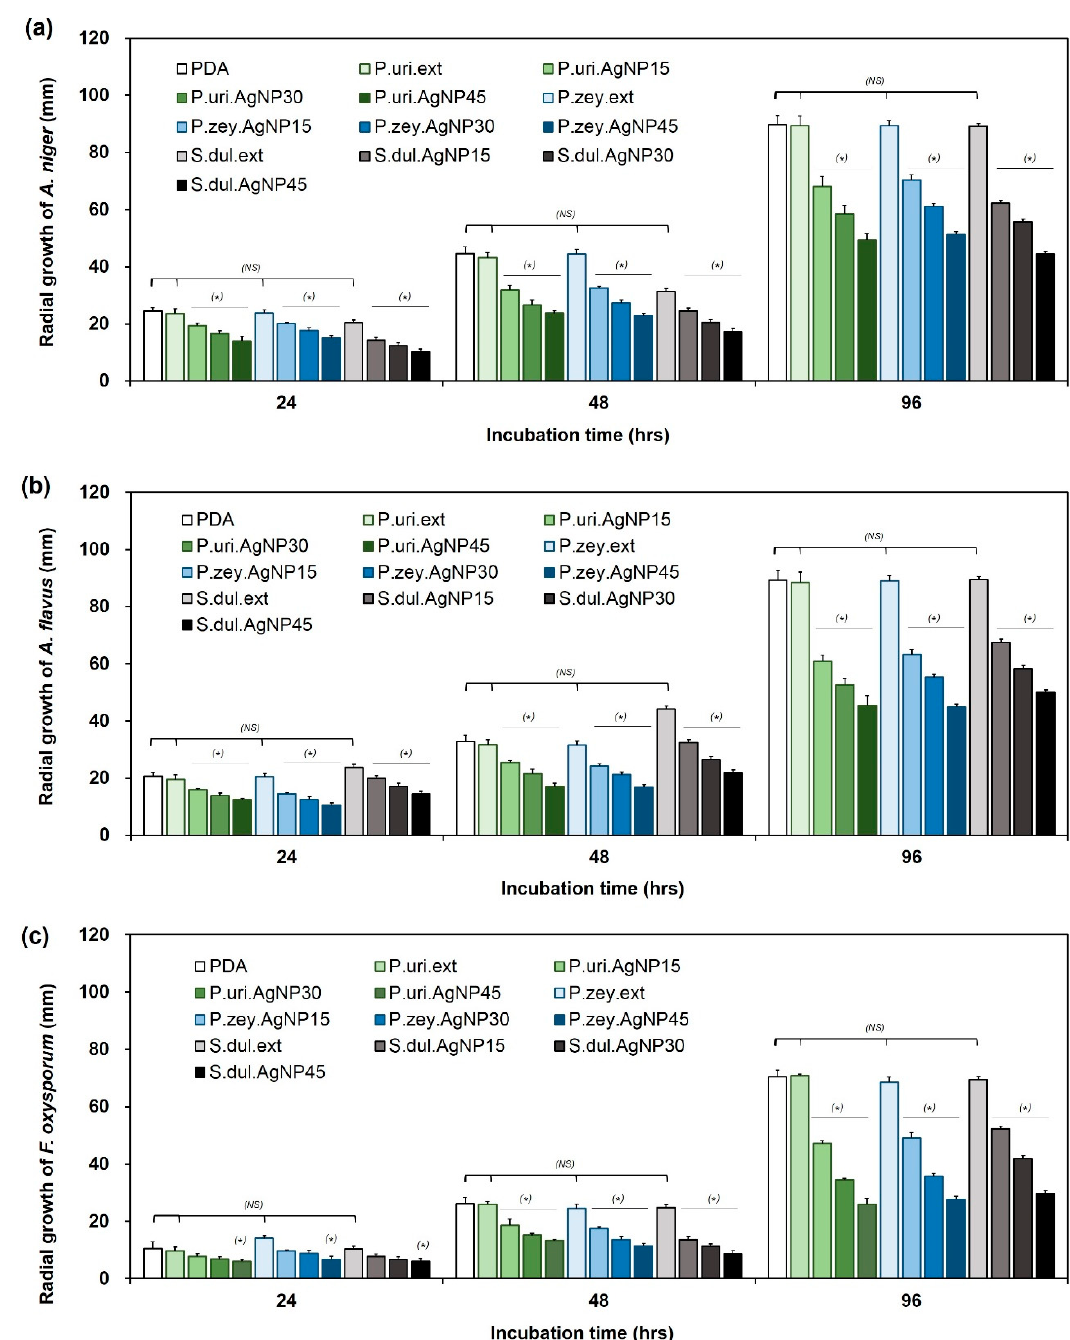
Figure 5. The mycelium diameter of A. niger ( a ), A. flavus ( b ) , and F. oxysporum ( c ) cultured on different agar matrices as a function of time interval. (PDA: potato dextrose agar dishes as a control; P.uri.ext, P.zey.ext, and S.dul.ext: the dishes made from PDA containing leaf extracts of Phyllanthus urinaria, Pouzolzia zeylanica , and Scoparia dulcis ; P.uri.AgNP15, P.uri.AgNP30, and P.uri.AgNP45: the dishes made from PDA containing 15, 30 and 45 ppm of P.uri.AgNPs silver nanoparticles; P.zey.AgNP15, P.zey.AgNP30, P.zey.AgNP45: the dishes made from PDA containing 15, 30 and 45 ppm of P.zey.AgNPs silver nanoparticles; S.dul.AgNP15, S.dul.AgNP30, S.dul.AgNP45: the dishes made from PDA containing 15, 30 and 45 ppm of S.dul.AgNPs silver nanoparticles (*) P < 0.05; NS: non-statistical different.